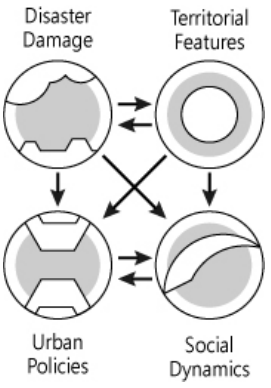
Figure 4. The influence relationship between four types